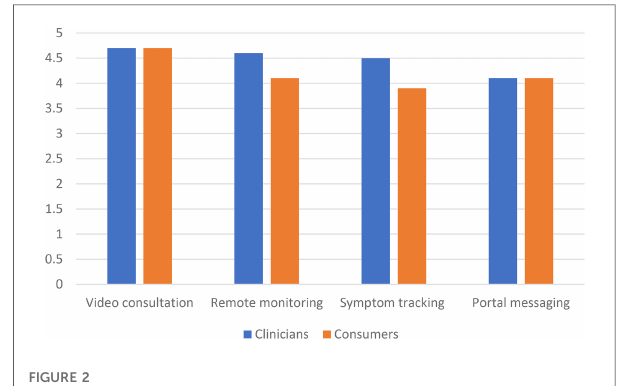
FIGURE 2 Most useful aspects of the model (with average rating out of